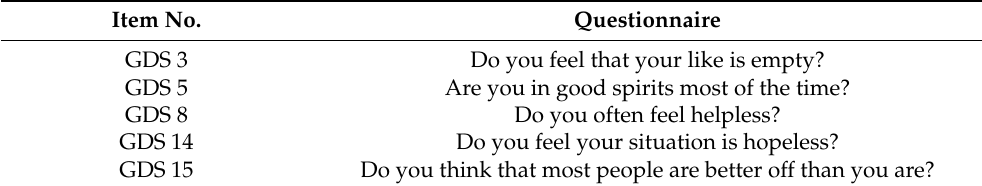
Table 1. Partial list of questionnaire items in K-SGDS. Item No.